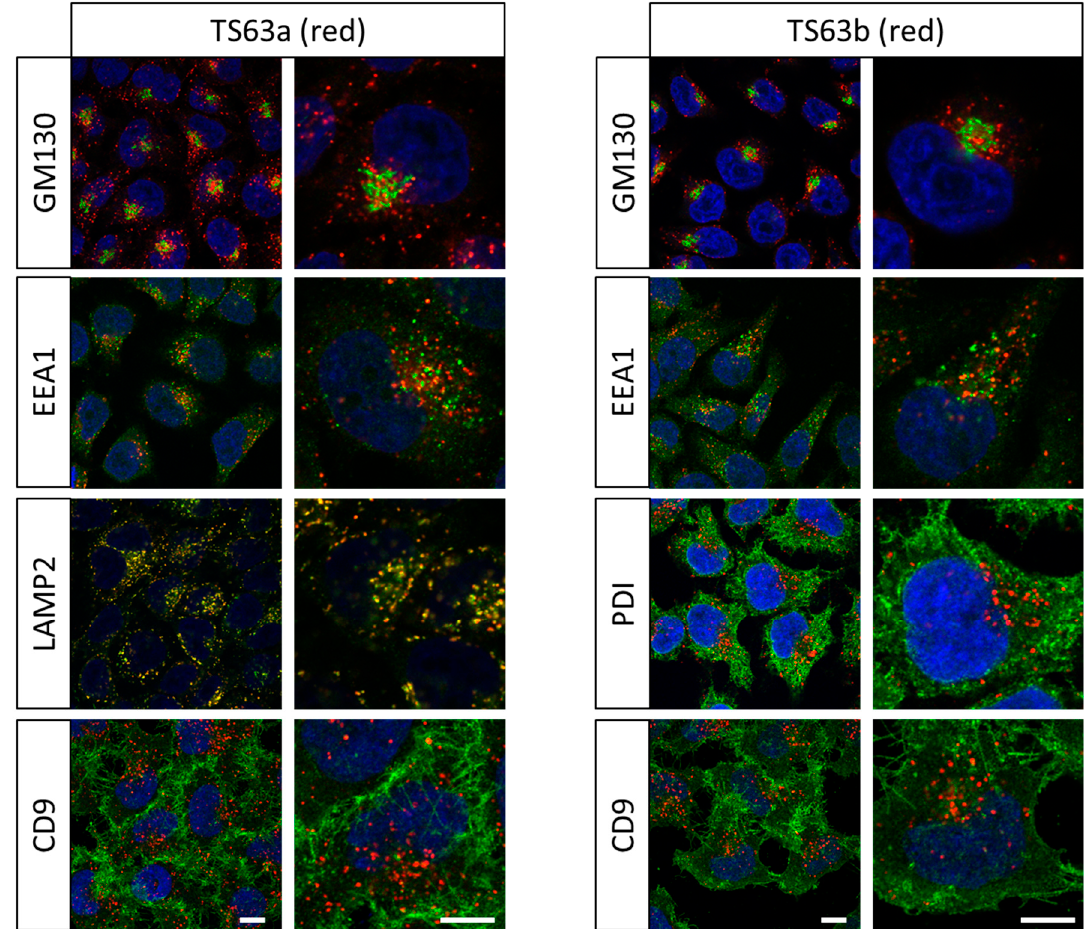
Figure 3. Confocal microscopy analysis of CD63 distribution and comparison with other organelle markers. HeLa cells were grown for two days on coverslips, fixed, permeabilized and stained with a combination of either TS63a or TS63b, and mAbs of different subclasses to markers of different compartments. The binding of the antibodies was revealed using goat polyclonal antibodies to mouse Ig subclasses coupled to AlexaFluor 488 or AlexaFluor 568. GM130: cis-Golgi; EEA1, early endosome; LAMP2: late endosome; PDI: endoplasmic reticulum; CD9: plasma membrane. Bar: 10 µm.